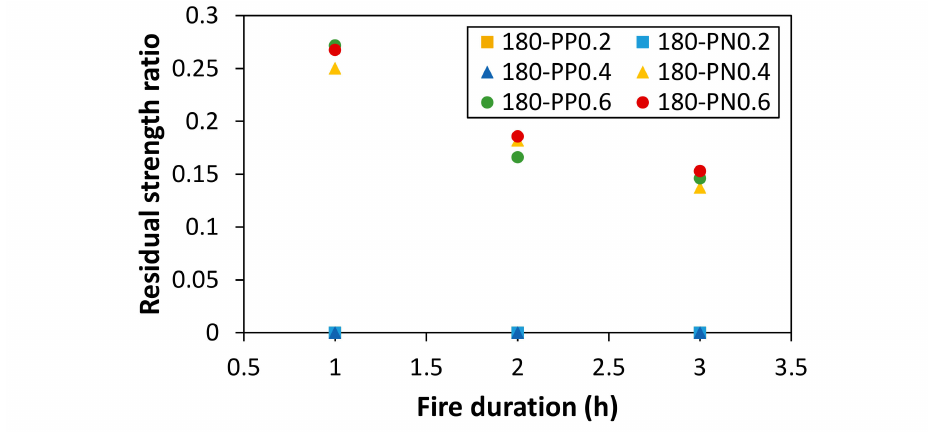
Figure 8. Effect of synthetic-fiber type and fire duration on direct tensile